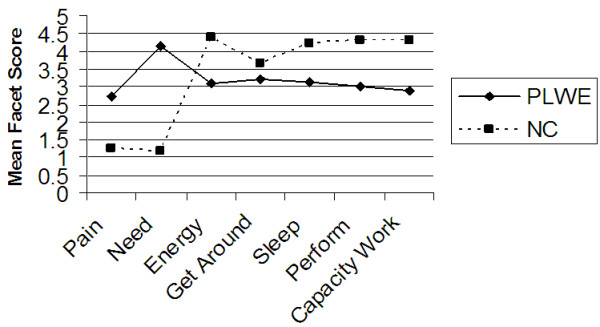
Facets determining the physical health QOL domain. X axis represents the seven facets that comprise the physical health QOL domain. Y axis represents the mean facet score (0 to 5).